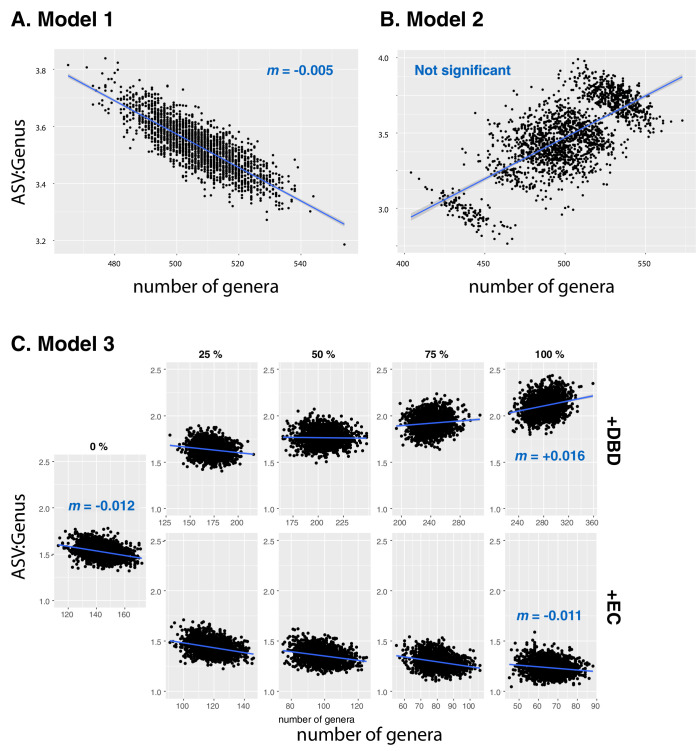
Null models based on Neutral Theory.Results are shown from data simulated under (A) neutral Model 1, (B) neutral Model 2, or (C) neutral Model 3. Model 1 is sampled from the zero-sum multinomial distribution with a single distribution for the whole dataset, while Model 2 includes a separate distribution for each of the 17 different environments (EMPO 3 biomes). In Model 3 (C), the effect of DBD (top rows) or EC (bottom rows) are ‘spiked in’ at different levels, ranging from 0 to 100% of ASVs in a sample. Blue lines show a linear fit, with slopes (m) estimated by GLMM in selected panels. See Methods for model details, and Table 2 and Supplementary file 3, Section 1.2 for full GLMM results.